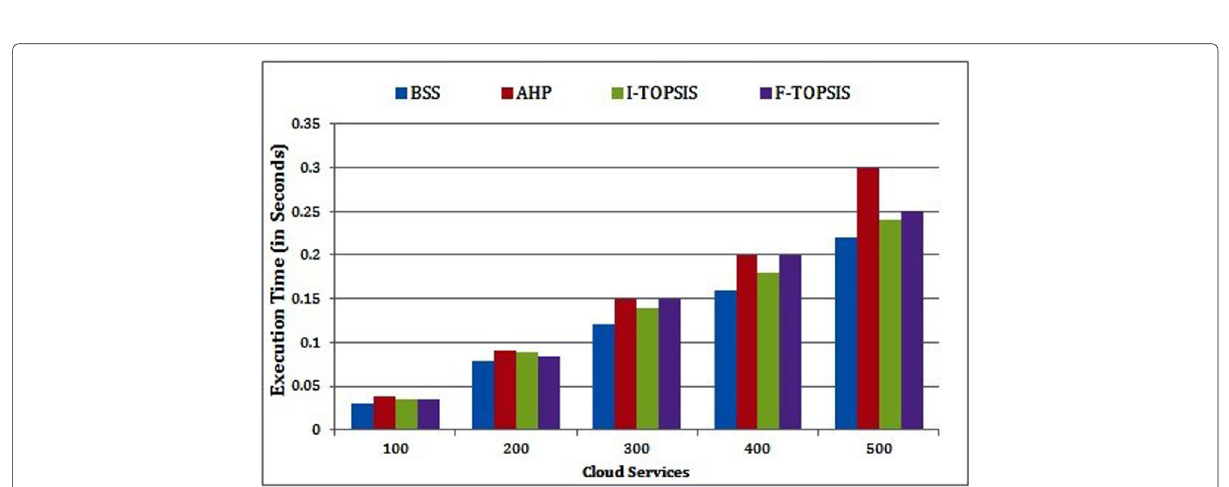
Fig. 5 Execution Time